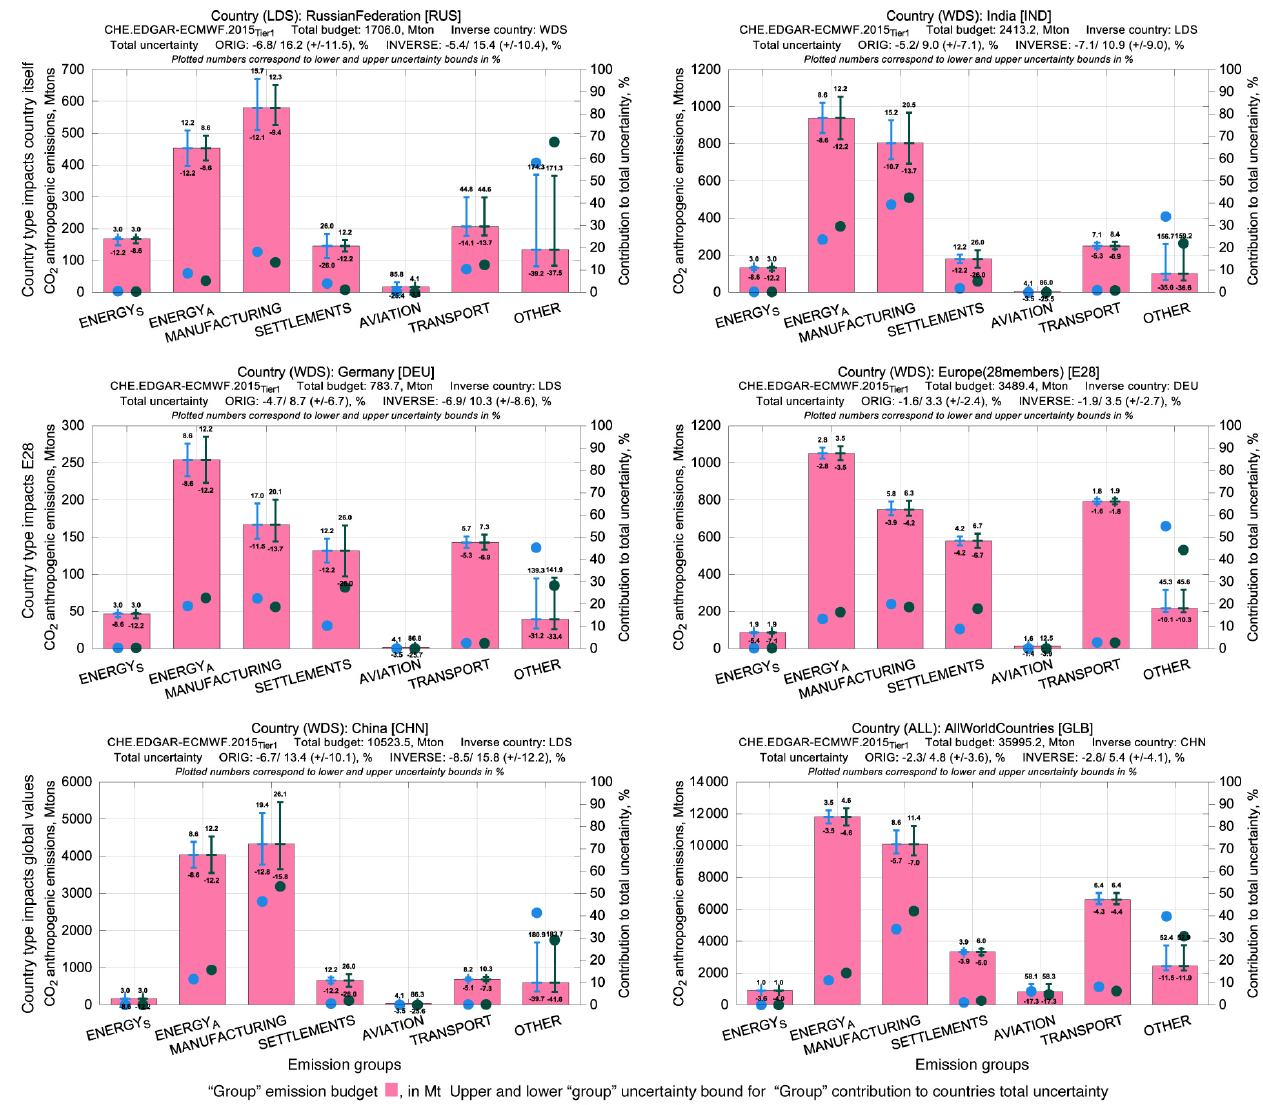
Figure 8. Emission budgets, uncertainties, and contributions in percentage to the total uncertainty in the country with their original and switched (inverse) types (countries with well- and less well-developed statistical infrastructures – WDSs and LDSs, respectively): impacting mainly the country itself, e.g. the Russian Federation (RUS) and India (IND); impacting also Europe (E28), e.g. Germany (DEU); impacting even global values, e.g. China